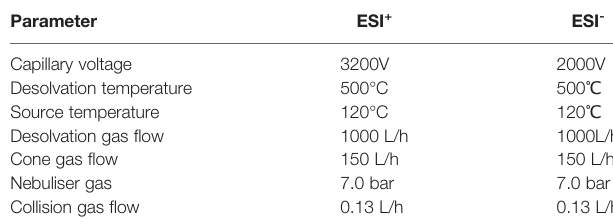
TABLE 4 | Analysis condition of positive and negative electrospray